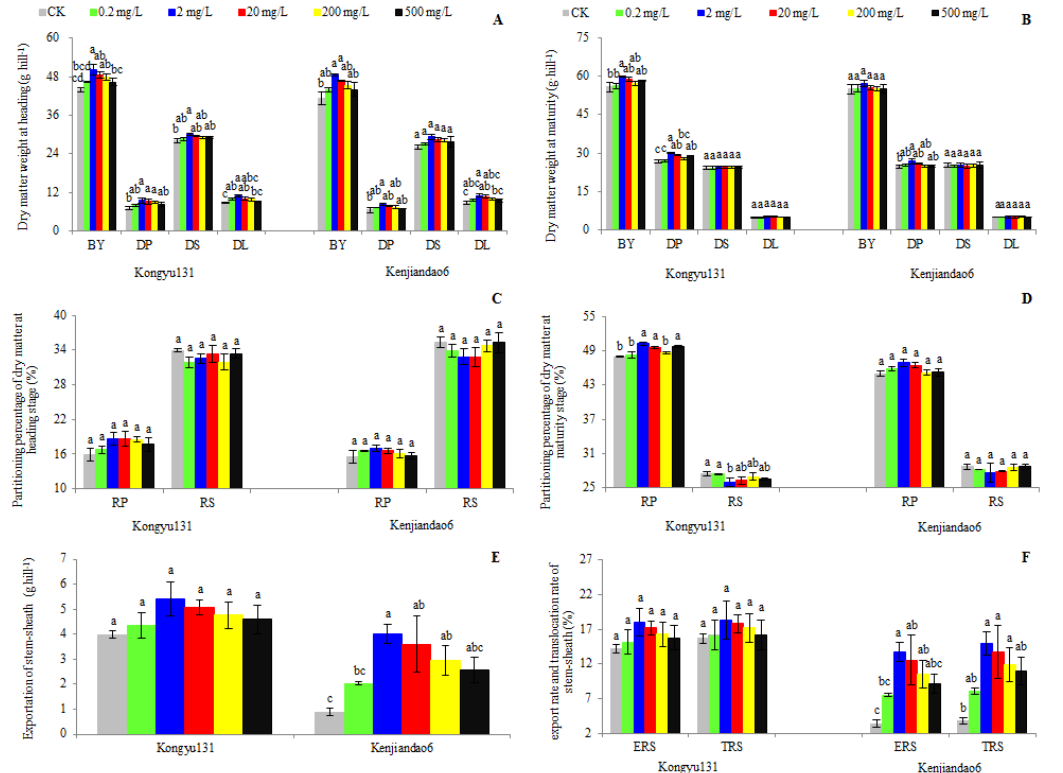
Figure 6. Effects of diethylaminoethyl hexanoate (DA-6) treatment on dry matter production under cold stress in Kongyu131 and Kenjiandao6. BY — biological yield; DP — panicle dry weight; DL — leaf dry weight; DS — stem-sheath dry weight; TRS — stem-sheath translocation rate; ES — stem-sheath exportation; RP — dry weight ratio of panicle to total plant; ERS — stem-sheath export rate; RS — dry weight ratio of stem-sheath to total plant. The letters above the columns indicate significant differ- ences ( p < 0.05). ( A ) Dry matter weight at heading, ( B ) Dry matter weight at maturity, ( C ) Partition- ing percentage of dry matter at heading stage, ( D ) Partitioning percentage of dry matter at maturity stage, ( E ) Exportation of stem-sheath, ( F ) Export rate and translocation rate of stem-sheath.